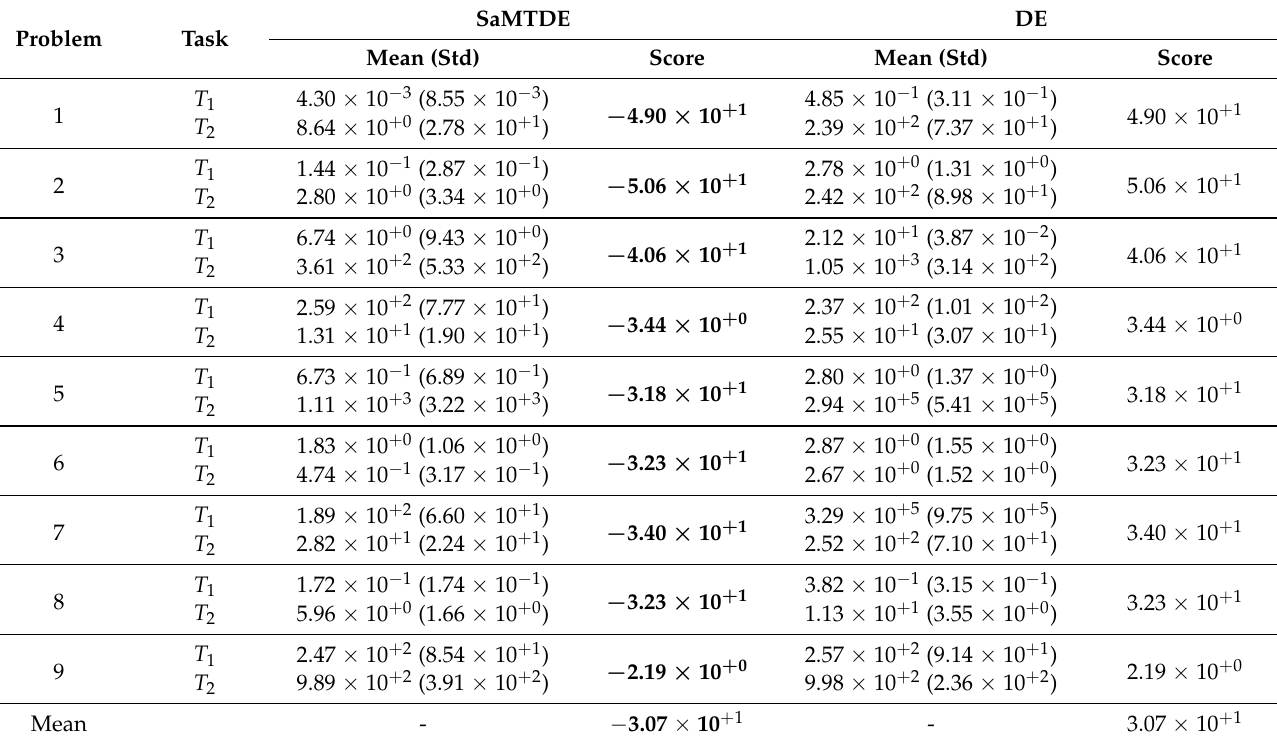
Table 3. Achieved FVs (mean, bracketed standard deviation) of the SaMTDE and DE. The better results are shown in bold. SaMTDE DE Problem Task Mean